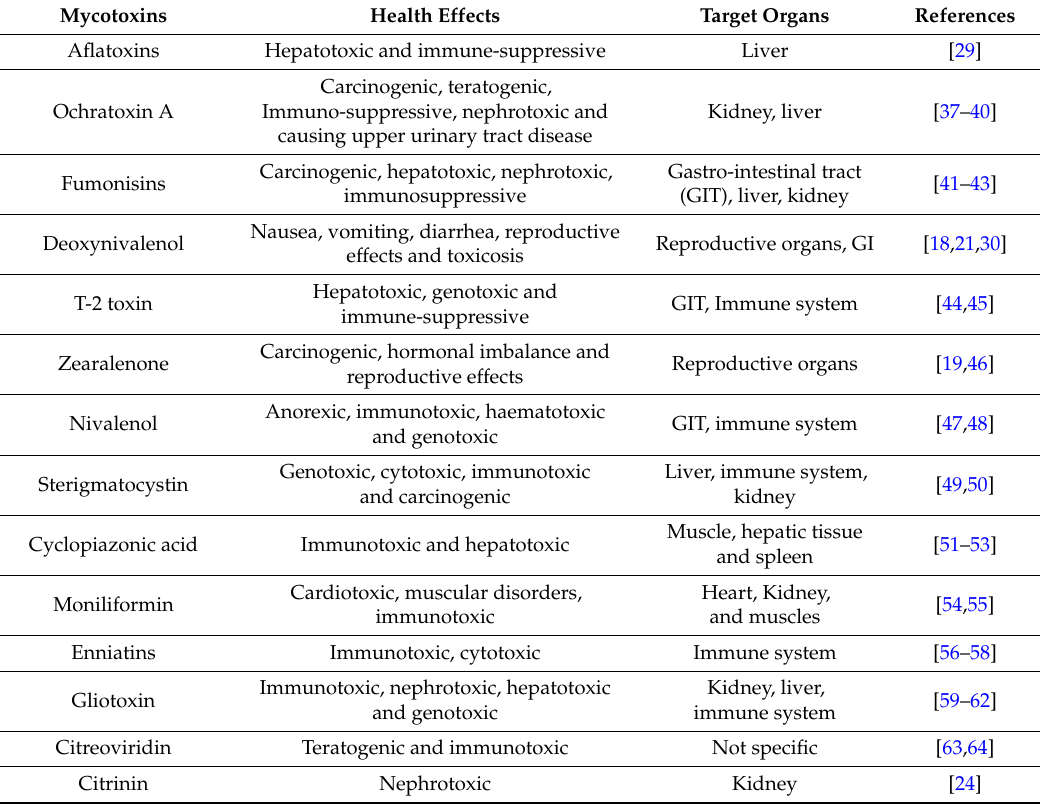
Table 2. Common mycotoxins, their health effects and target